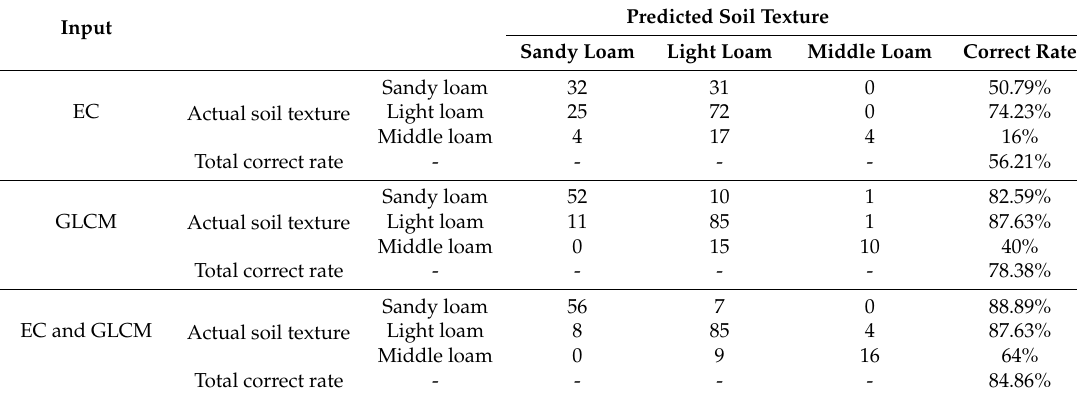
Table 3. Soil texture measurement result